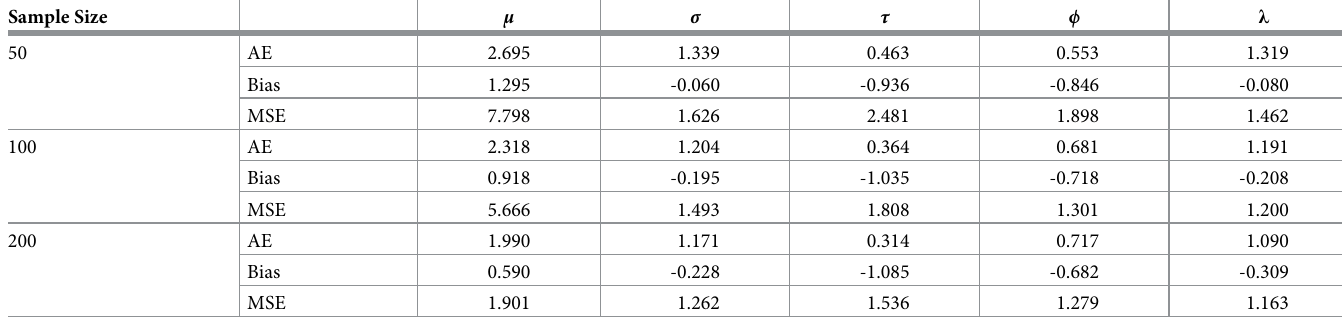
Table 2. Simulation result of MBTED(3.2,1.3,1.5,0.5,0.5). Sample